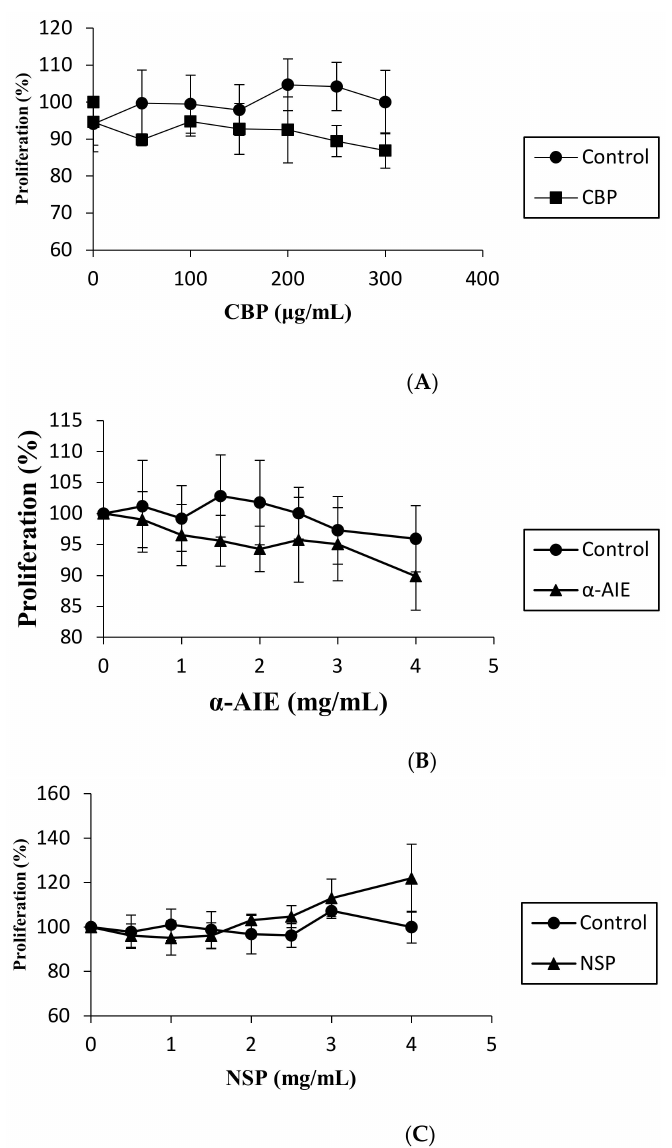
Figure 1. The cytotoxicity of CBP ( A ), α -AIE ( B ), and NSP ( C ). Cultures in basal medium served as control. Three independent experiments were performed, and the data were shown as mean ± SD. There is no significant difference between the experimental groups and the control